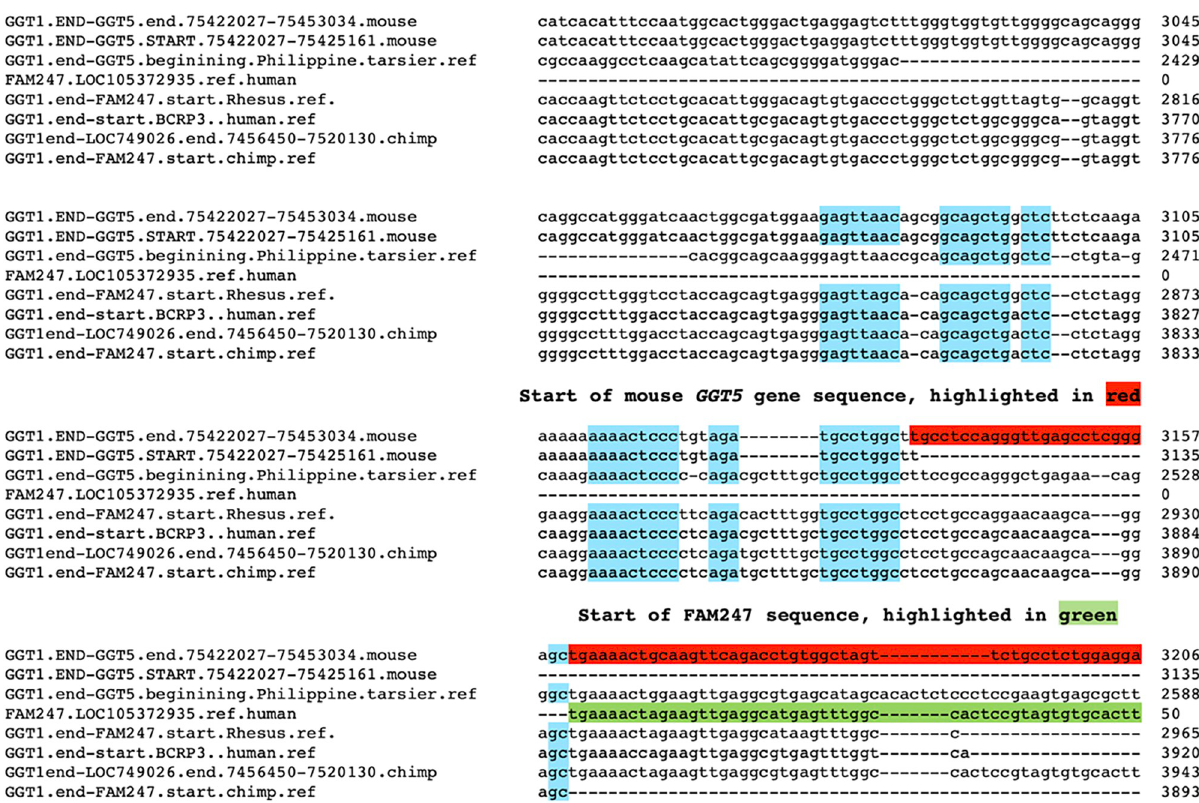
Fig 3. Small segment of alignment of spacer sequences showing the start of the FAM247 sequence and conserved sequences. Alignment of five spacer sequences from mouse, tarsier, Rhesus, chimpanzee and humans. Only section of the spacer 3’ terminal ends, the start of the mouse GGT5 and the start of FAM247 sequences are shown. Spacer terminal ends: Mouse, at 3161 bp; tarsier, 2872 bp; Rhesus, 2933 bp; chimpanzee, 3893 bp; human, 3920 bp. Light blue highlighted, conserved sequence blocks that are conserved in all species analyzed,. Green highlighted, the start of FAM247 sequence. Red highlighted, start of GGT5 gene sequence in the mouse genome. In the higher primates, since GGT5 is distal to GGT1 , the start of the GGT5 sequence can not be used to define the 3’ ends of the spacers and the FAM247 sequence has been used. The lengths of spacer 3’ ends vary between species. However, the spacer end of the chimpanzee is shown, i.e., position 3893 bp of the chimpanzee sequence from GGT1.end-FAM247.start.chimp. ref, which ends before the FAM247 sequence begins. In humans, the BCRP3 gene contains the FAM247 sequence but starting with position 33 of the FAM247, with positions 1–32 bp of FAM247 present in the human spacer, therefore we have defined the start of the BCRP3 gene sequence as the human spacer 3’ end. The alignment of the complete sequences used is in S2